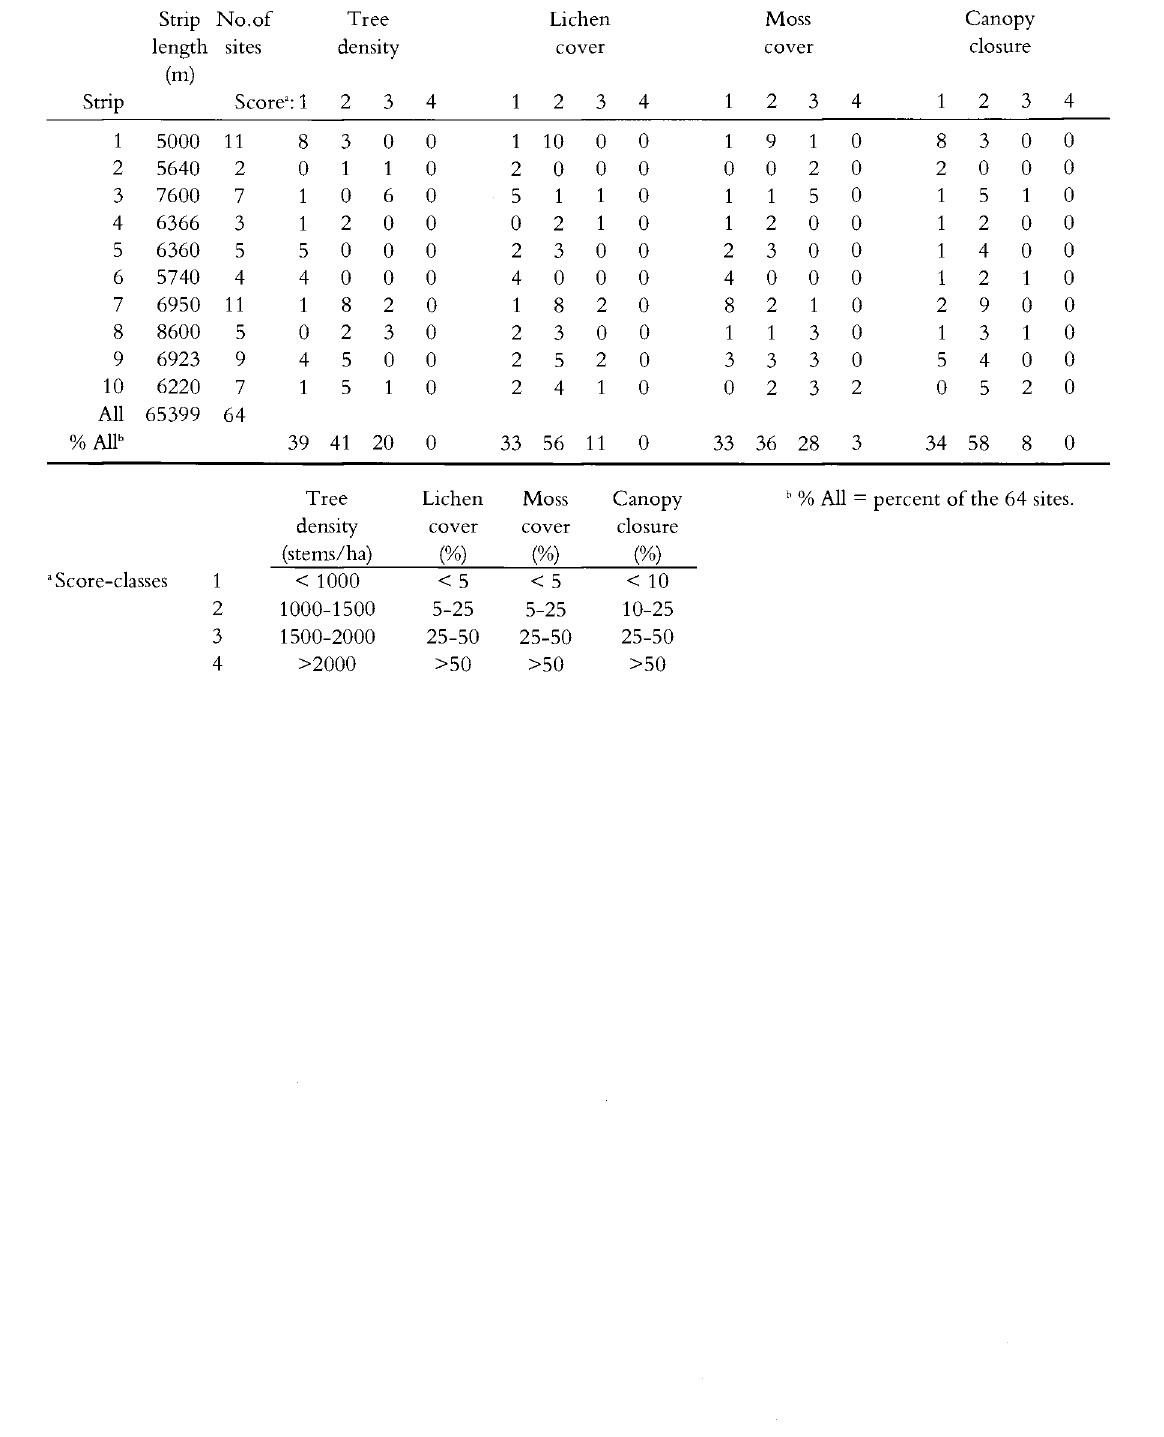
Table 6. Score-frequencies of four main site attributes on 10 survey transects. Strip No.of Tree Lichen Moss Canopy length sites density cover